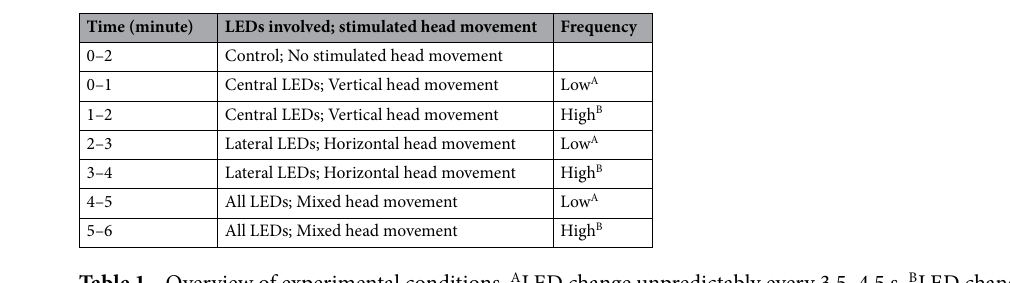
Table 1. Overview of experimental conditions. A LED change unpredictably every 3.5–4.5 s. B LED change unpredictably every 2–3